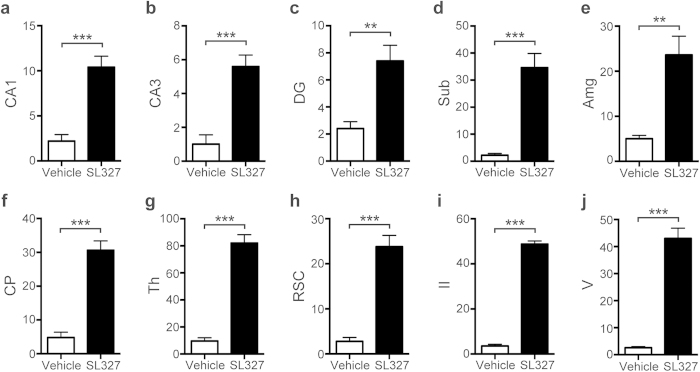
Quantification confirmed the significant increase of apoptosis in the brain from mice administered SL327 at P6 compared with vehicle controls. Numbers of cleaved caspase-3 positive cells. (a) CA1 = hippocampal CA1 region, (b) CA3 = hippocampal CA3 region, (c) DG = dentate gyrus, (d) Sub = subiculum, (e) Amg = amygdala, (f) CP = caudate/putamen, (g) Th = thalamus, (h) RSC = retrosplenial cortex, (i) II = cortex layer II in parietal cortex, (j) V = cortex layer V in parietal cortex. Data are represented as mean ± SEM (n = 5 mice for each). **P < 0.01, ***P < 0.001.